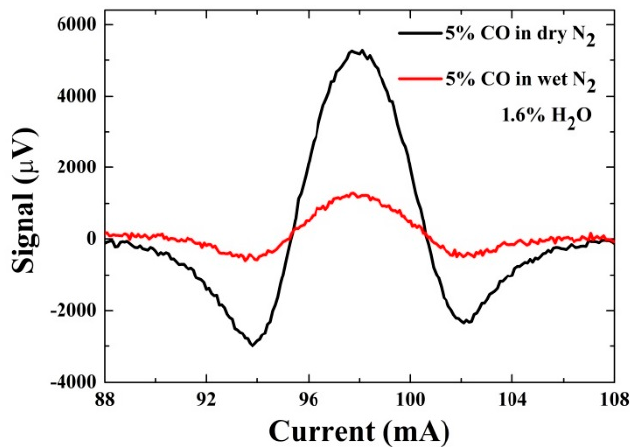
Figure 10. QEPAS signals obtained in the dry N 2 and wet N 2 as a function a laser current.